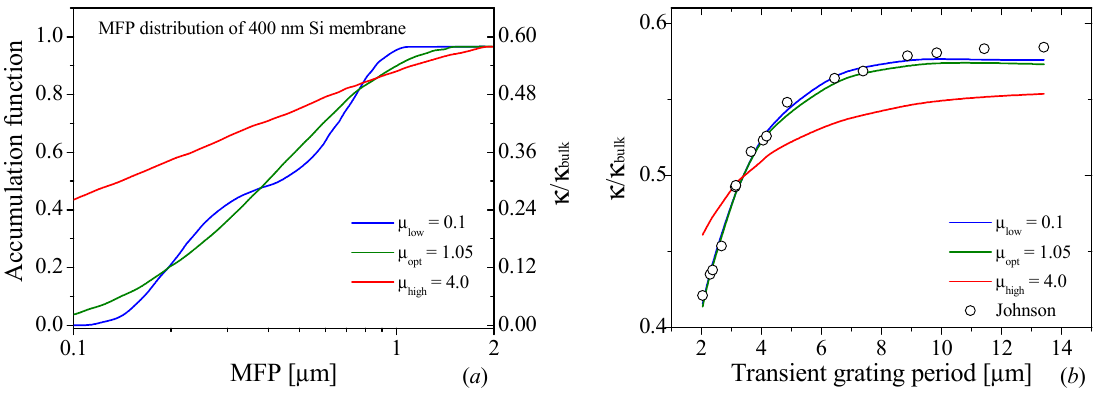
Figure 4. ( a ) Phonon mean free path distribution of the accumulation function for a 400 nm Si film reconstructed for µ opt (green line). The blue and red lines are the result obtained using a low and high value of µ , respectively. ( b ) Thermal conductivity of 400 nm Si film corresponding to the different accumulation functions (red, green, and blue lines) for different transient grating periods in the experimental technique [17].